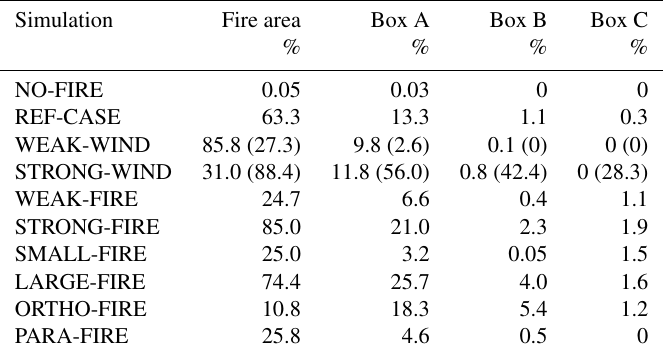
Figure 8. PDFs of the near-surface wind velocity within the fire area for the different case simulations (solid lines) with respect to the PDFs of the non-fire situations (dashed lines). Shown are the impacts of different (a) ambient wind velocities, (b) fire intensities, (c) fire sizes, and (d) fire shapes and orientation – always with respect to the REF-CASE simulation. Table 2. Fraction of the wind velocities larger than the non-fire limit for the direct fire area and the three boxes A, B, and C with different distances from the fire area (see Fig. 2). For the majority of the simulations with an ambient wind velocity of 3ms − 1 , this upper non-fire threshold lies at 6ms − 1 (frequency of occurrence > 99 . 99%). For the WEAK-WIND and STRONG-WIND simulations, different threshold values of 4 and 8ms − 1 are used. Additionally, the fractions concerning the 6ms − 1 limit are indicated in brackets here, too. Simulation Fire area Box